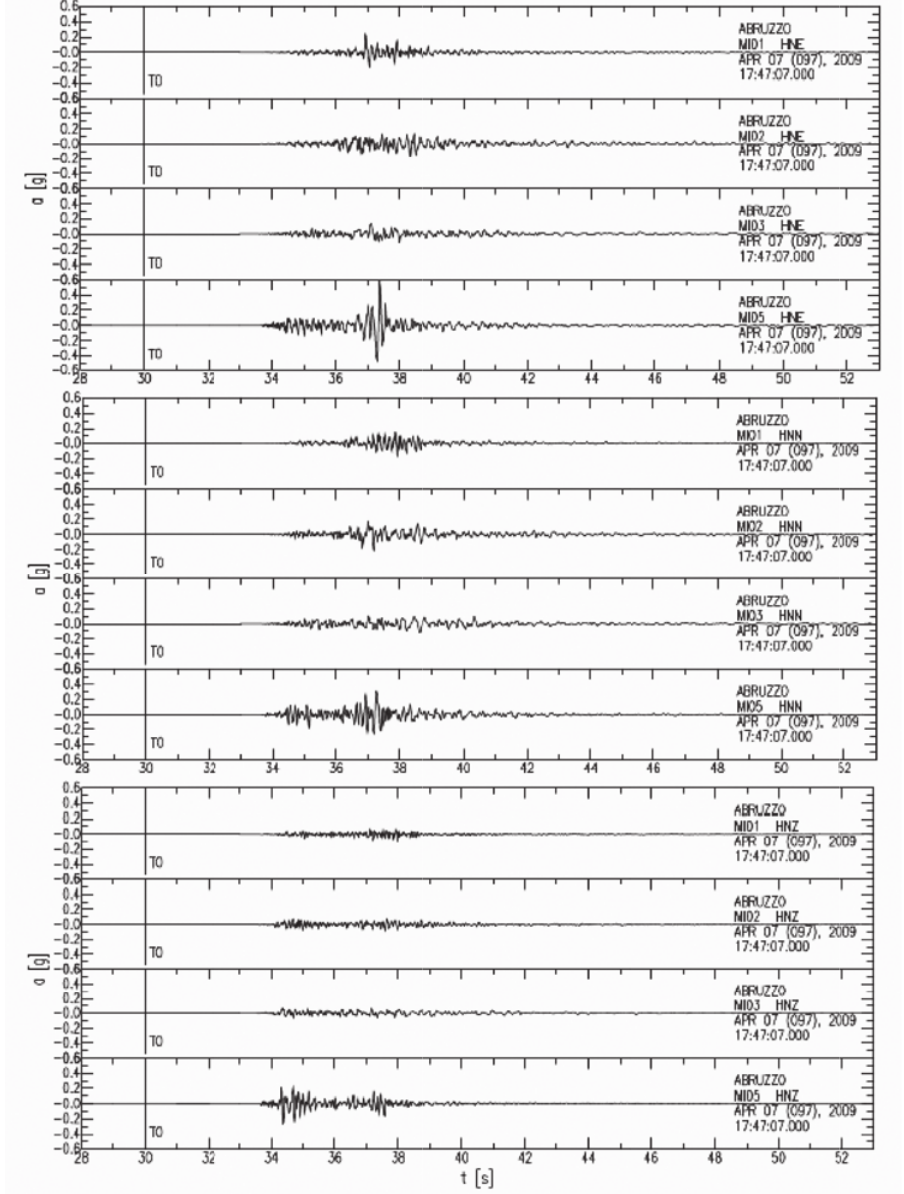
Figure 7. April 7, 2009, ML = 5.3, aftershock recorded at strong-motion stations MI01, MI02, MI03 and MI05 (top panel, East-West; middle panel, North- South; and bottom panel, vertical components) in the near source (epicentral distances <10